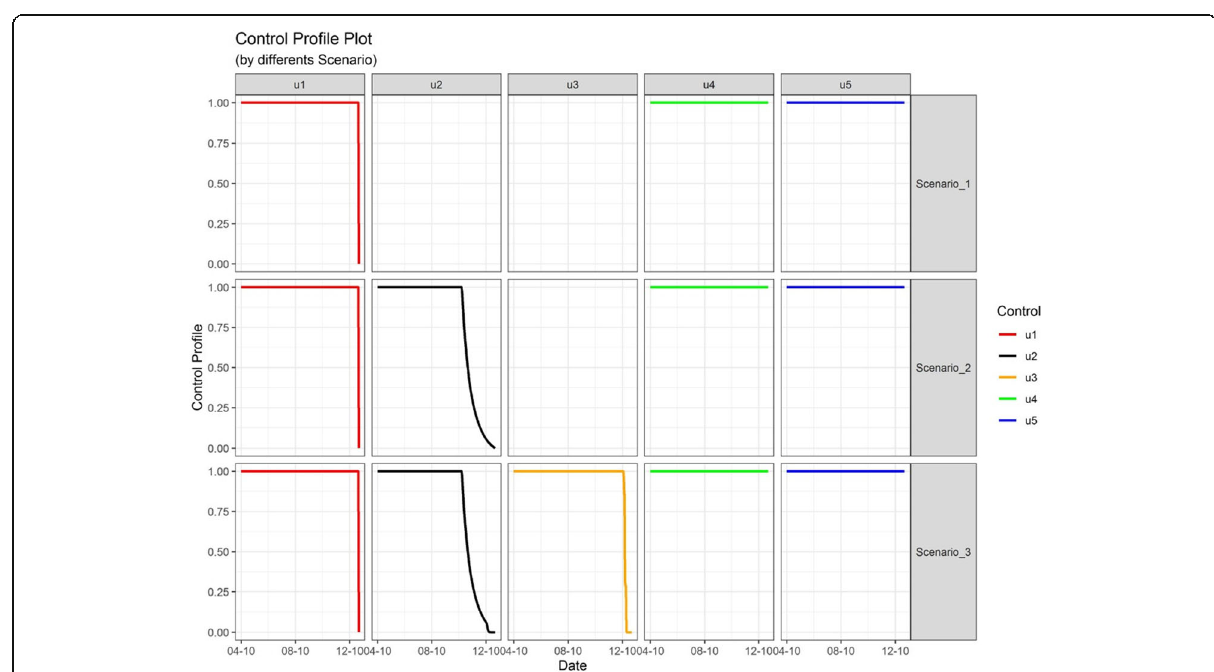
Fig. 3 Control Profile of COVID-19 Cases on Different Scenario in Indonesia